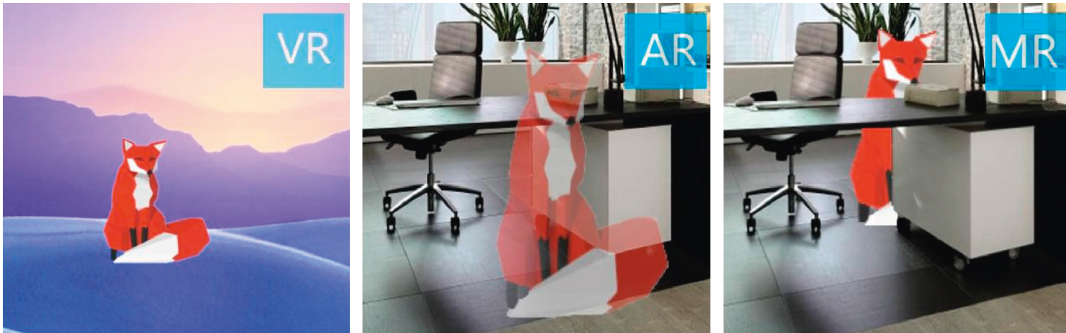
Figure 6: Difference between 3 main domains of immersive technology: VR is an artificial world; AR is an object of augmented reality seen on the screen; MR is a 3D object seen as a hologram which is totally